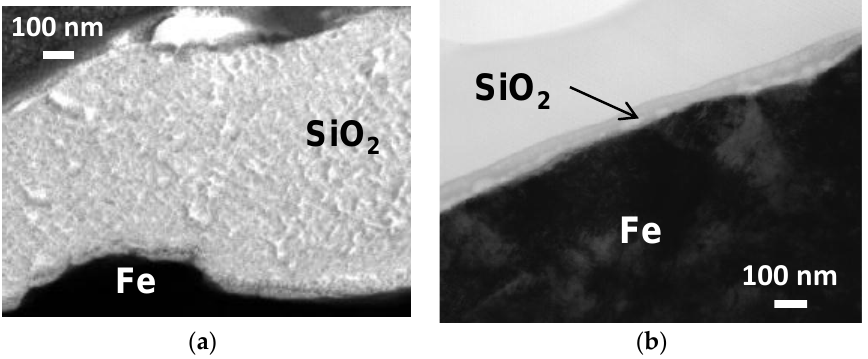
Figure 5. TEM images of silica layers on iron powder particles with Sr-B-P-O insulating layers coated five times by ( a ) colloidal silica; and ( b ) silica nanosheets.